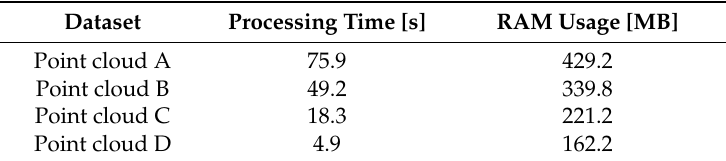
Table 1. The measured processing time and RAM consumption for every processed